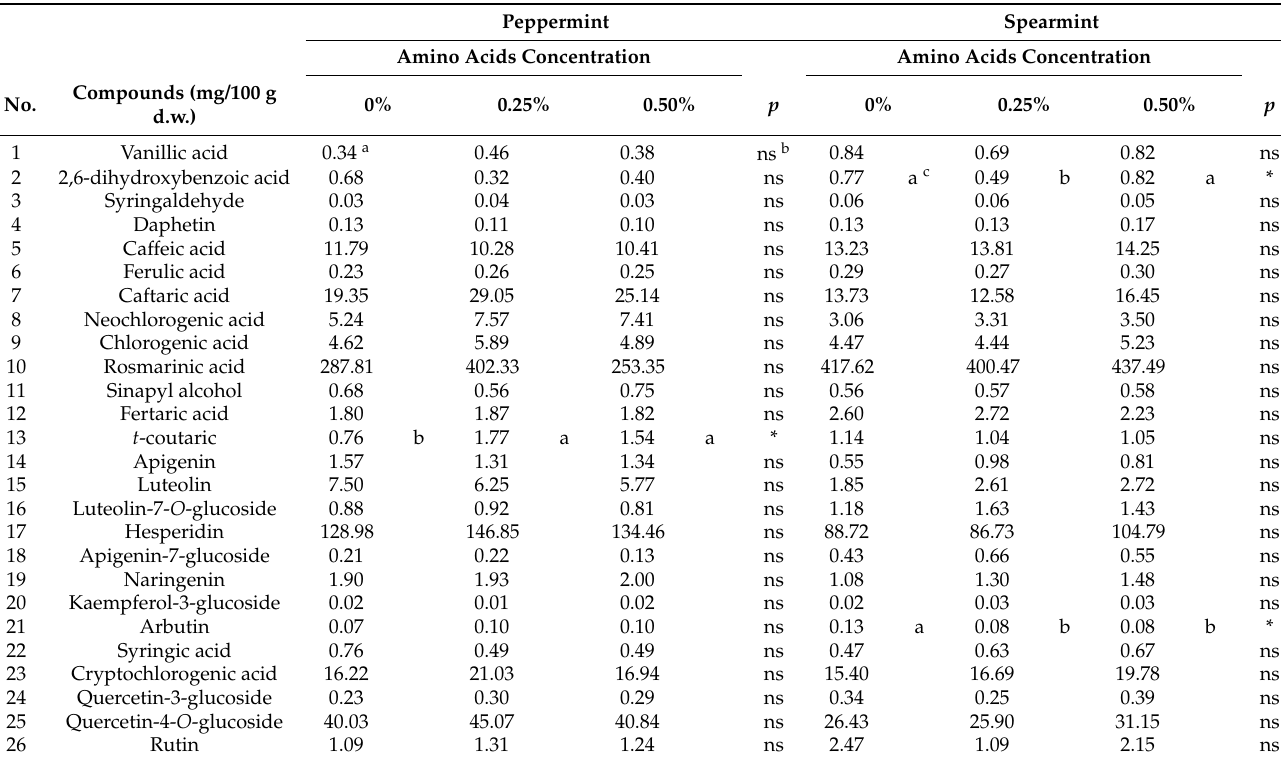
Table 3. Polyphenolic composition of peppermint and spearmint plants grown in floating system in which 0, 0.25 or 0.50% of a commercial PH solution (Amino16 ® ) was added. Peppermint Spearmint Amino Acids Concentration Amino Acids Concentration Compounds (mg/100 g No. d.w.)